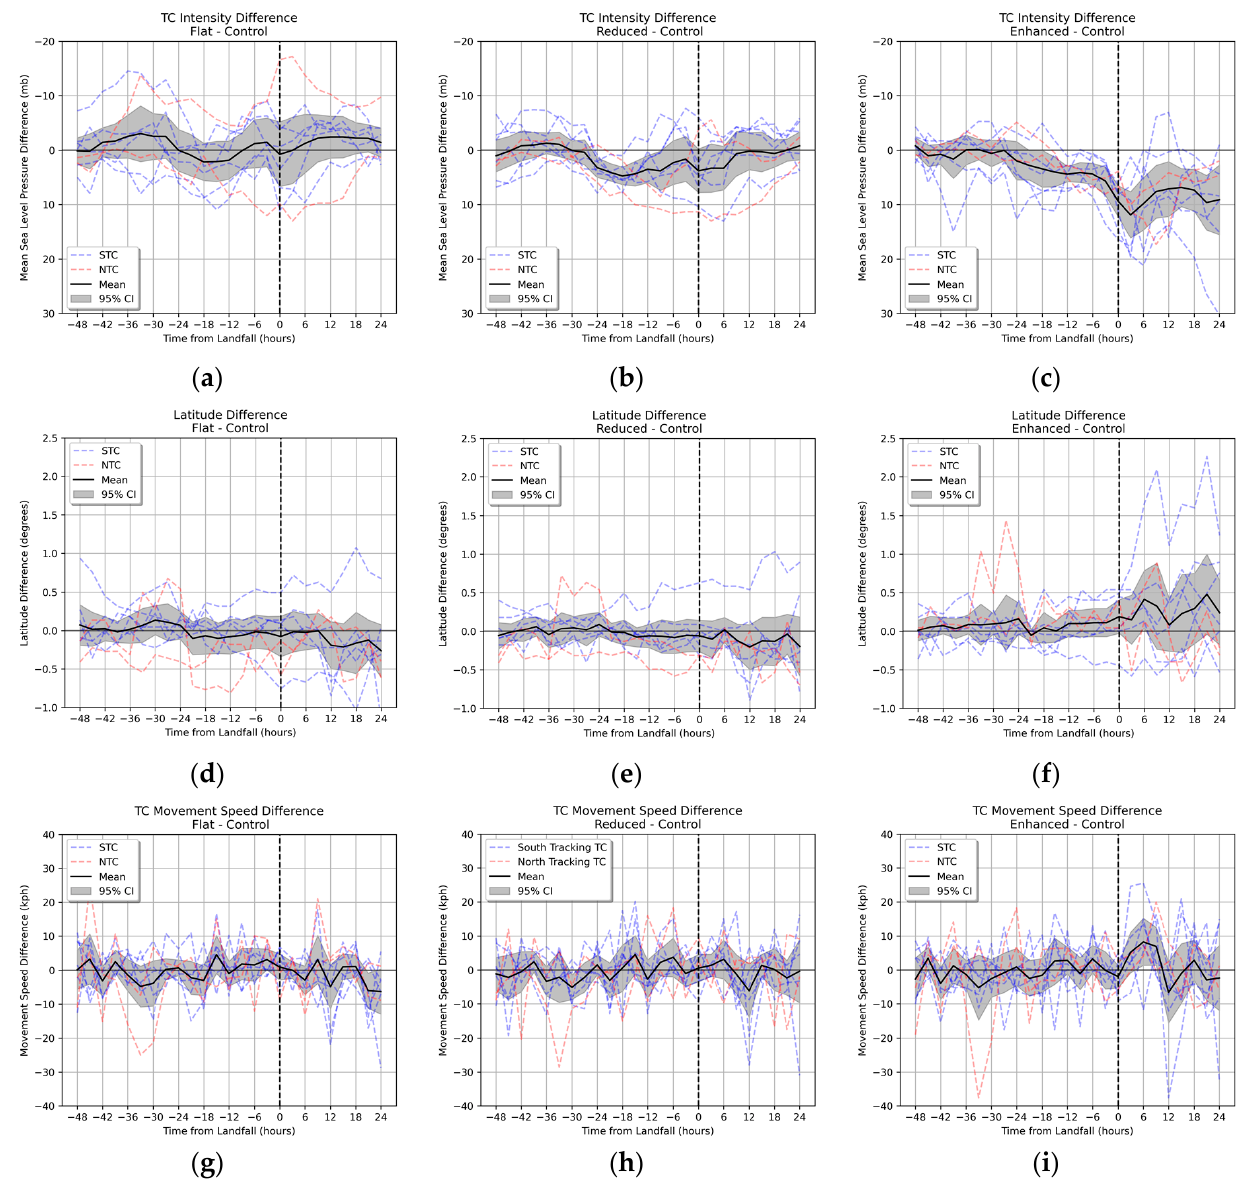
Figure 5. TC intensity comparison for ( a ) Flat—Control, ( b ) Reduced—Control, and ( c ) Enhanced— Control; TC location comparison for ( d ) Flat—Control, ( e ) Reduced—Control, and ( f ) Enhanced— Control; TC movement speed comparison for ( g ) Flat—Control, ( h ) Reduced—Control, and ( i ) Enhanced—Control. Take note of the inverted y-axis for ( a – c ) to highlight the decrease in the intensity of the TCs. The red dashed lines represent the NTCs, with the blue dashed lines representing the STCs. The black lines represent the means of all cases, with the grey shading showing the 95% CIs based on SE by adding or subtracting 1.96 × SE from the means. The vertical black dashed lines are the time of landfall, or 𝑡 (cid:3404) 0 .